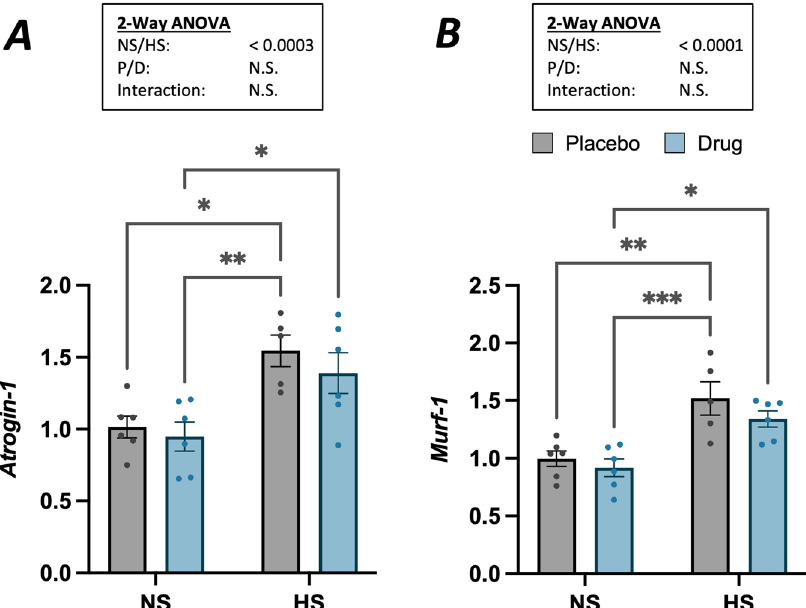
Fig. 3 Relative gene expression levels from rt-PCR analysis of the tibialis anterior. Relative gene expression levels are shown for: A Atrogin- 1 and B MuRF-1 normalized to a beta-actin control. Two-way ANOVA revealed signi fi cant increases in expression for Atrogin-1 and MuRF-1 with hindlimb suspension ( p < 0.001) but no signi fi cant impact of myostatin inhibition. Posthoc Tukey ’ s comparisons showed signi fi cant differences as shown by dissimilar letters. Data are presented as mean ± SEM, n = 5 – 6 mice/group; α =